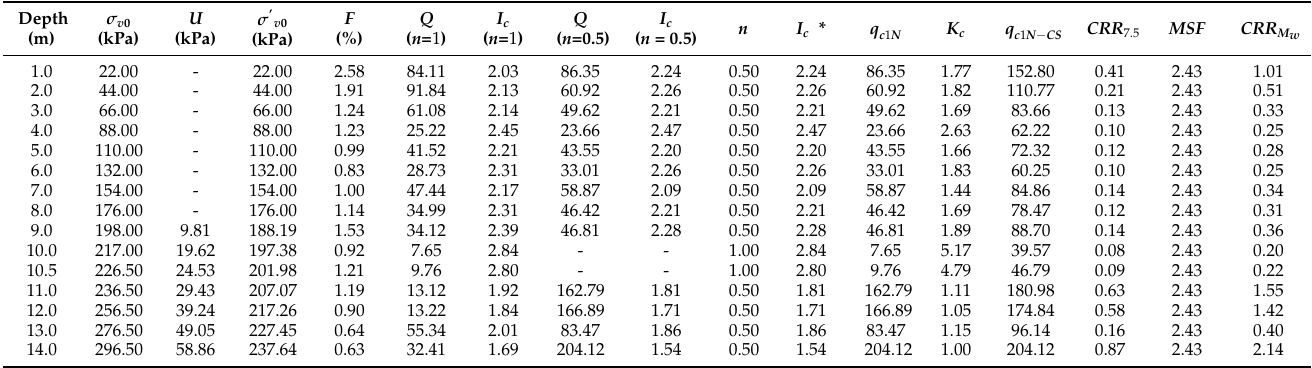
Table 2. Cyclic resistance ratio